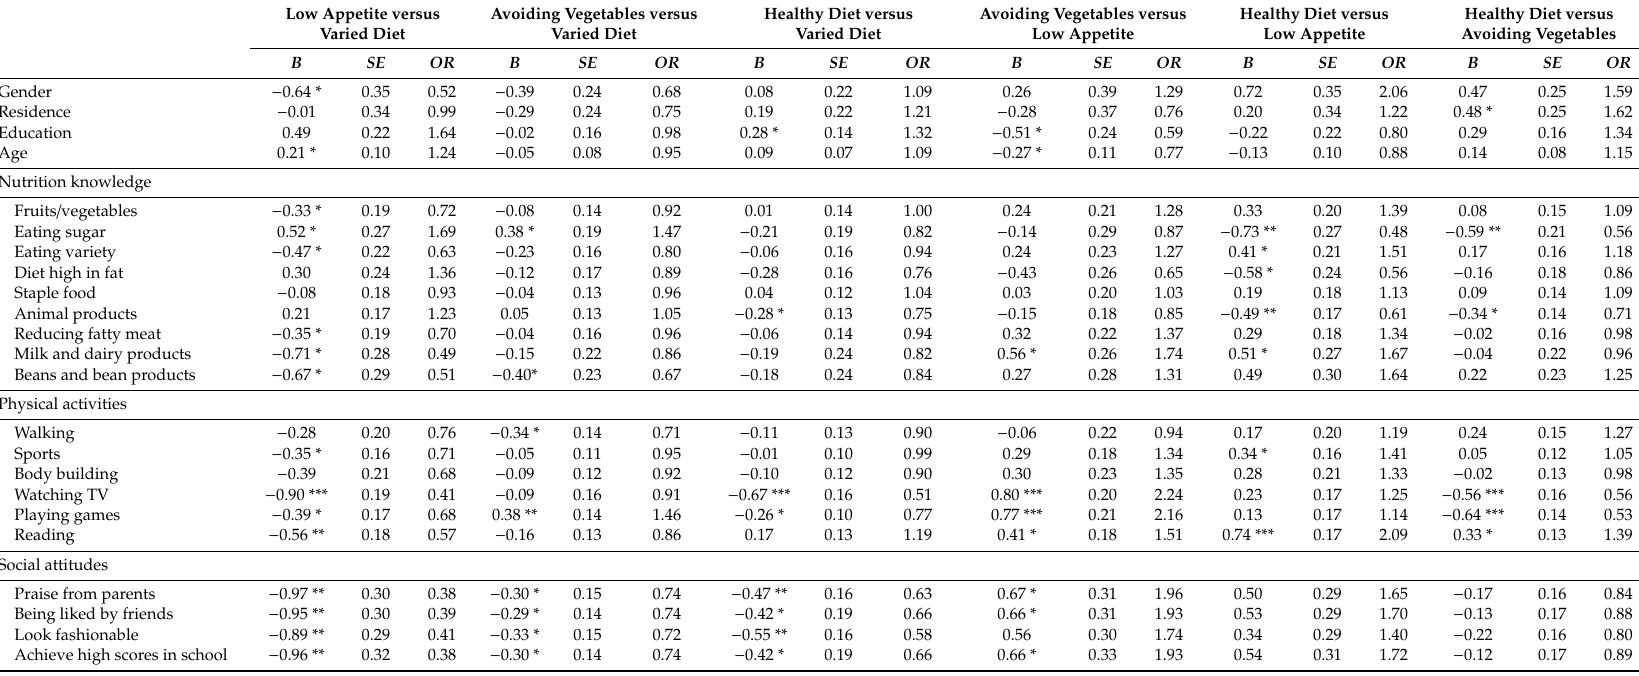
Table 4. Multinomial logistic regression predicting latent class membership as a function of